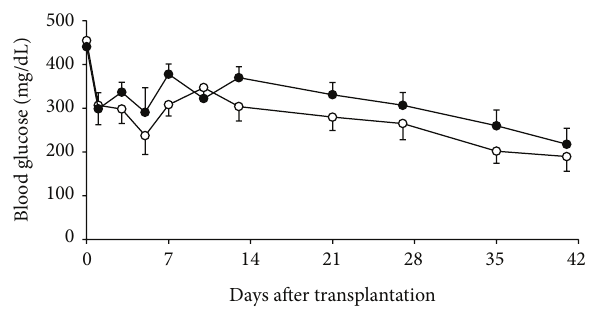
Figure 2: Body weight changes in islet recipients with (solid circle) and without (open circle) MK-0431 treatment.